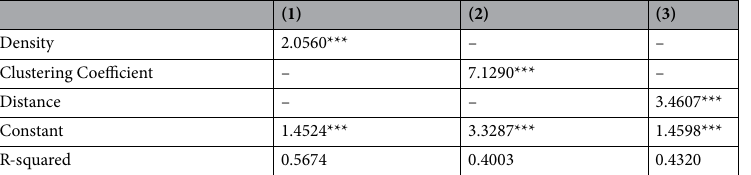
Table 3. The overall effect of the traffic correlation network structure in the Pearl River Delta. ***, ** and * indicate that the significance levels are 1%, 5% and 10%, respectively.